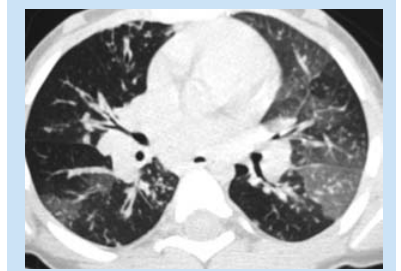
Fig. 9a. Septal lines.